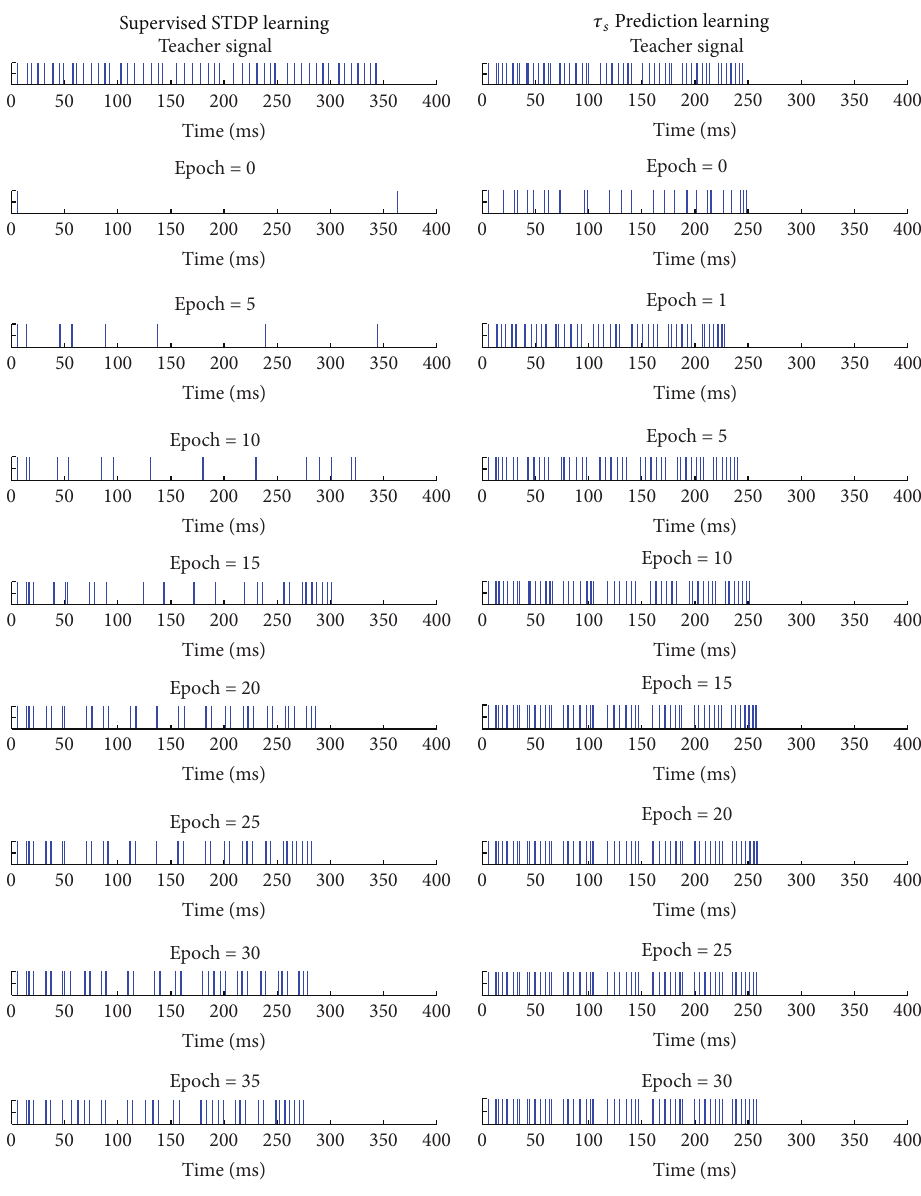
Figure 12: Evolution of output spikes from a CD neuron during Supervised STDP Learning and 𝜏 𝑠 Prediction learning process. The output spikes are shown as small bar plot indicating the exact output spike time in milliseconds. The input spikes are obtained from identical subject and the output spikes shown also include start and end cues but exclude the imaginary